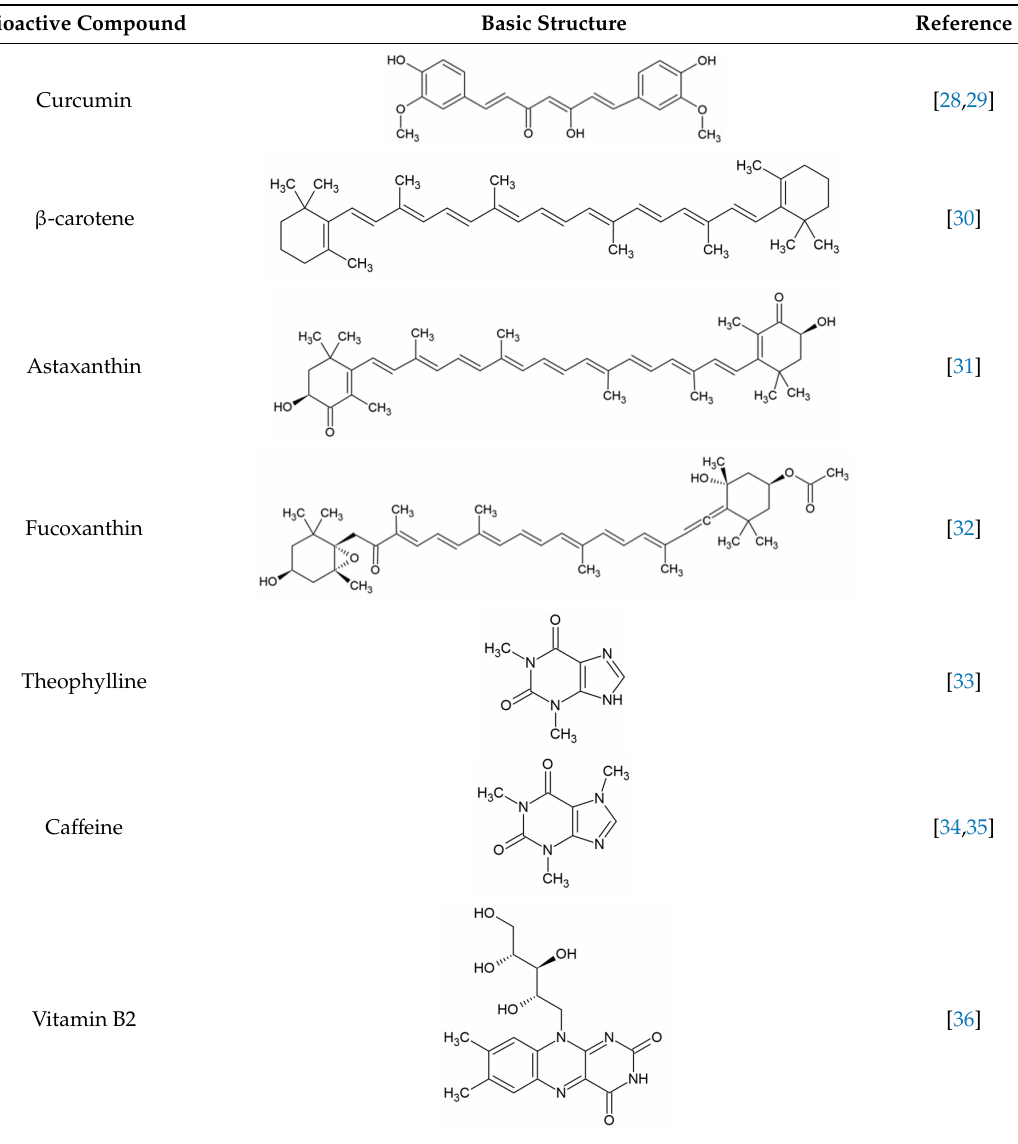
Table 1. Some encapsulated food bioactive